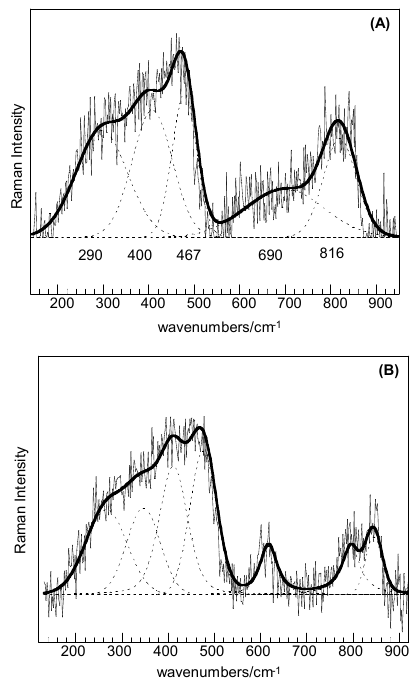
Figure 3. Full scan Raman spectra: ( A ) SiO 2 –C sample; ( B ) SiO 2 –C sample treated 24 h at 250 °C in liquid water.